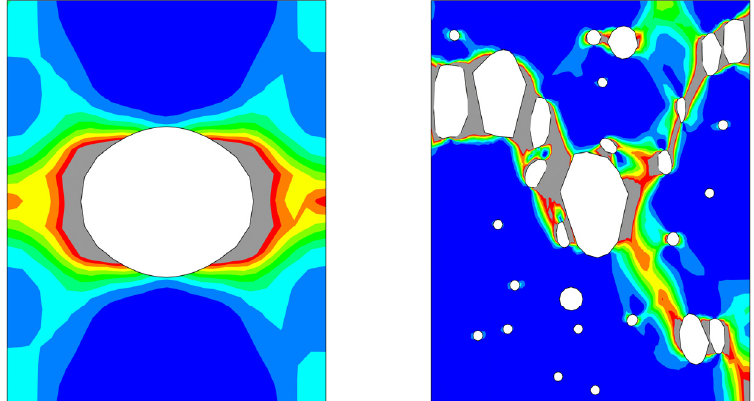
Figure 2: Equivalent strain distribution inside two RVE.